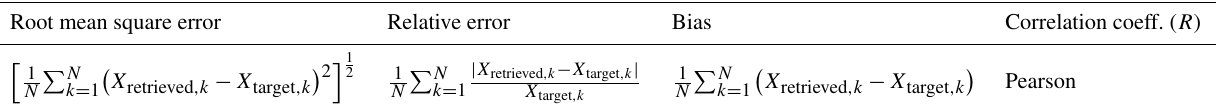
X retrieved and X target are length- N real positive vectors with the values of predicted (i.e., algorithm-retrieved) and target values, respectively. For the calculation of relative error, X target ,k = 0 gm − 2 is excluded from the